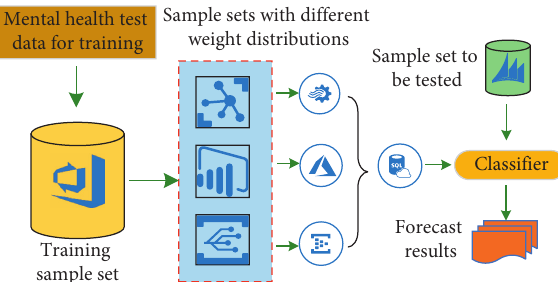
Figure 2: Prediction model of mental